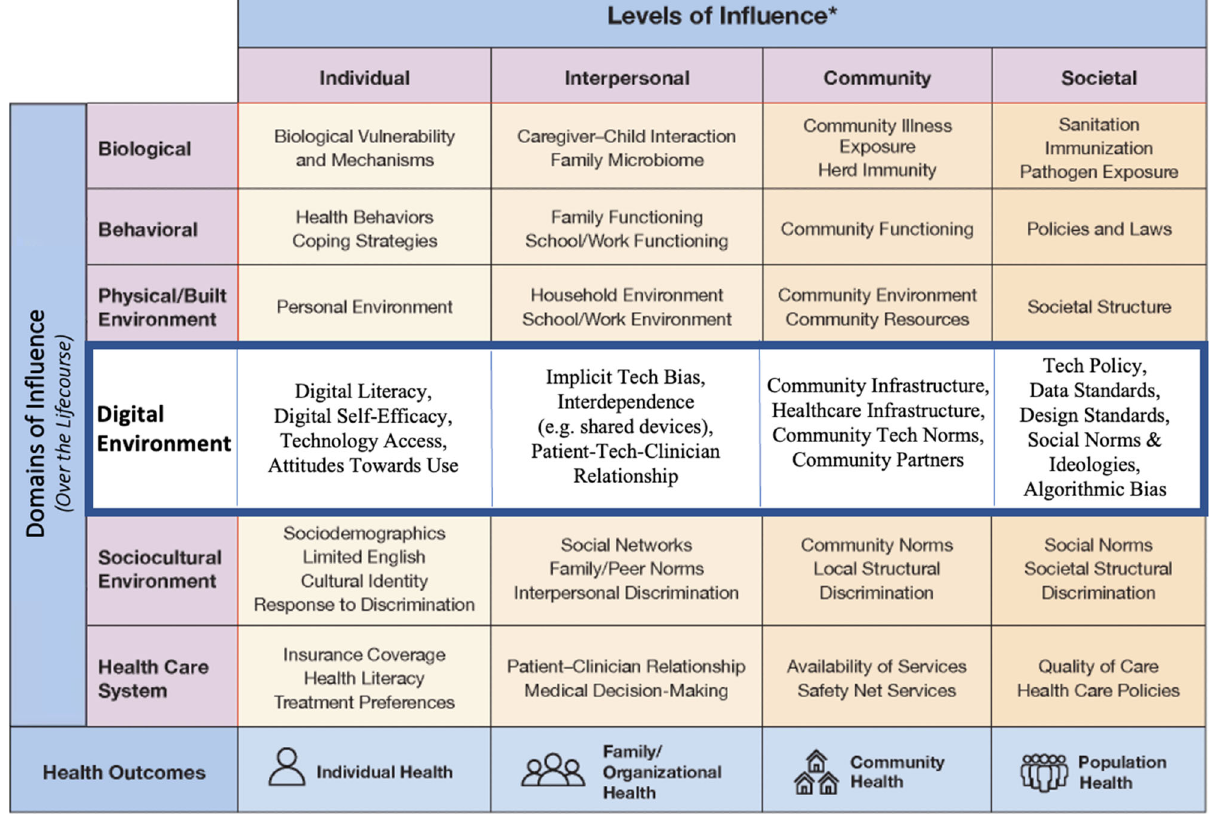
Fig. 1 Framework for digital health equity. National Institute on Minority Health and Health Disparities Research Framework Expanded for Digital Health